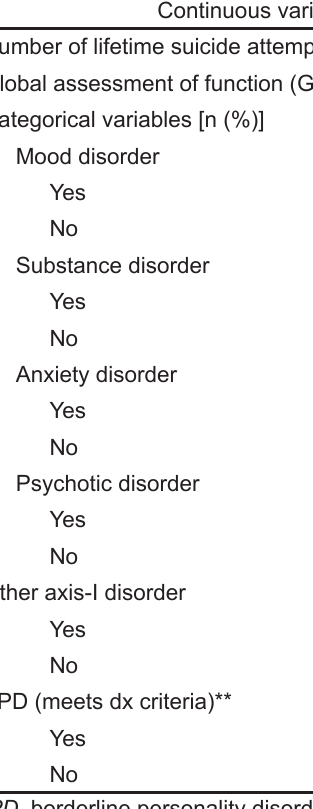
BPD, borderline personality disorder *Totals do not always equal 177 due to missing data. **Borderline Personality Disorder (BPD) information not obtained for Rochester